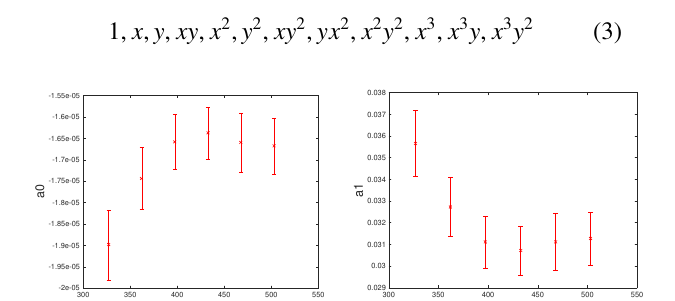
Figure 2 . Virtual eye socket showing 625 pupil centers. Each center corresponds to an eye orientation that points the optical-axis of the eye towards a scene target on a plane 1 m from the eye, and each point on the plane corresponds to an evenly distributed 25 × 25 grid point in the scene camera. Samples were split into 7 groups based on their P y values by discretizing the Y axis. Samples in the middle group are shown in a di ff erent color.